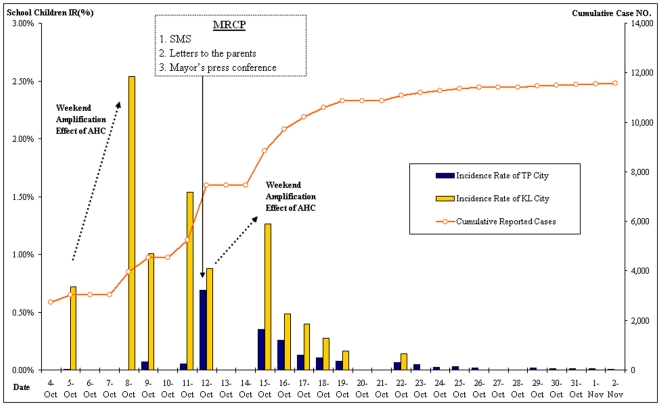
Incidence Rate (IR) and Cumulative Number of AHC Cases among School Children in Taipei City and Keelung City, October - November 2007.The figure's arrow indicates the weekend in which children stayed at home instead of attending school. The MRCP was launched on October 12th in Taipei City, causing the incidence rate (IR) of AHC to decline more rapidly in Taipei City than in Keelung City, where AHC cases continued to increase.